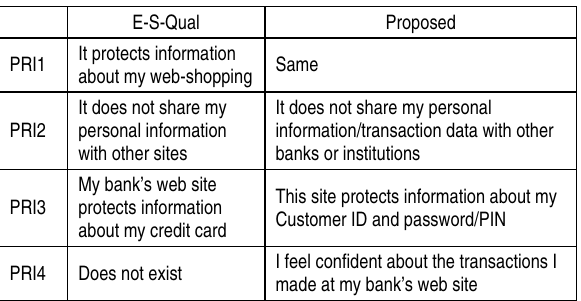
Table 6. Privacy